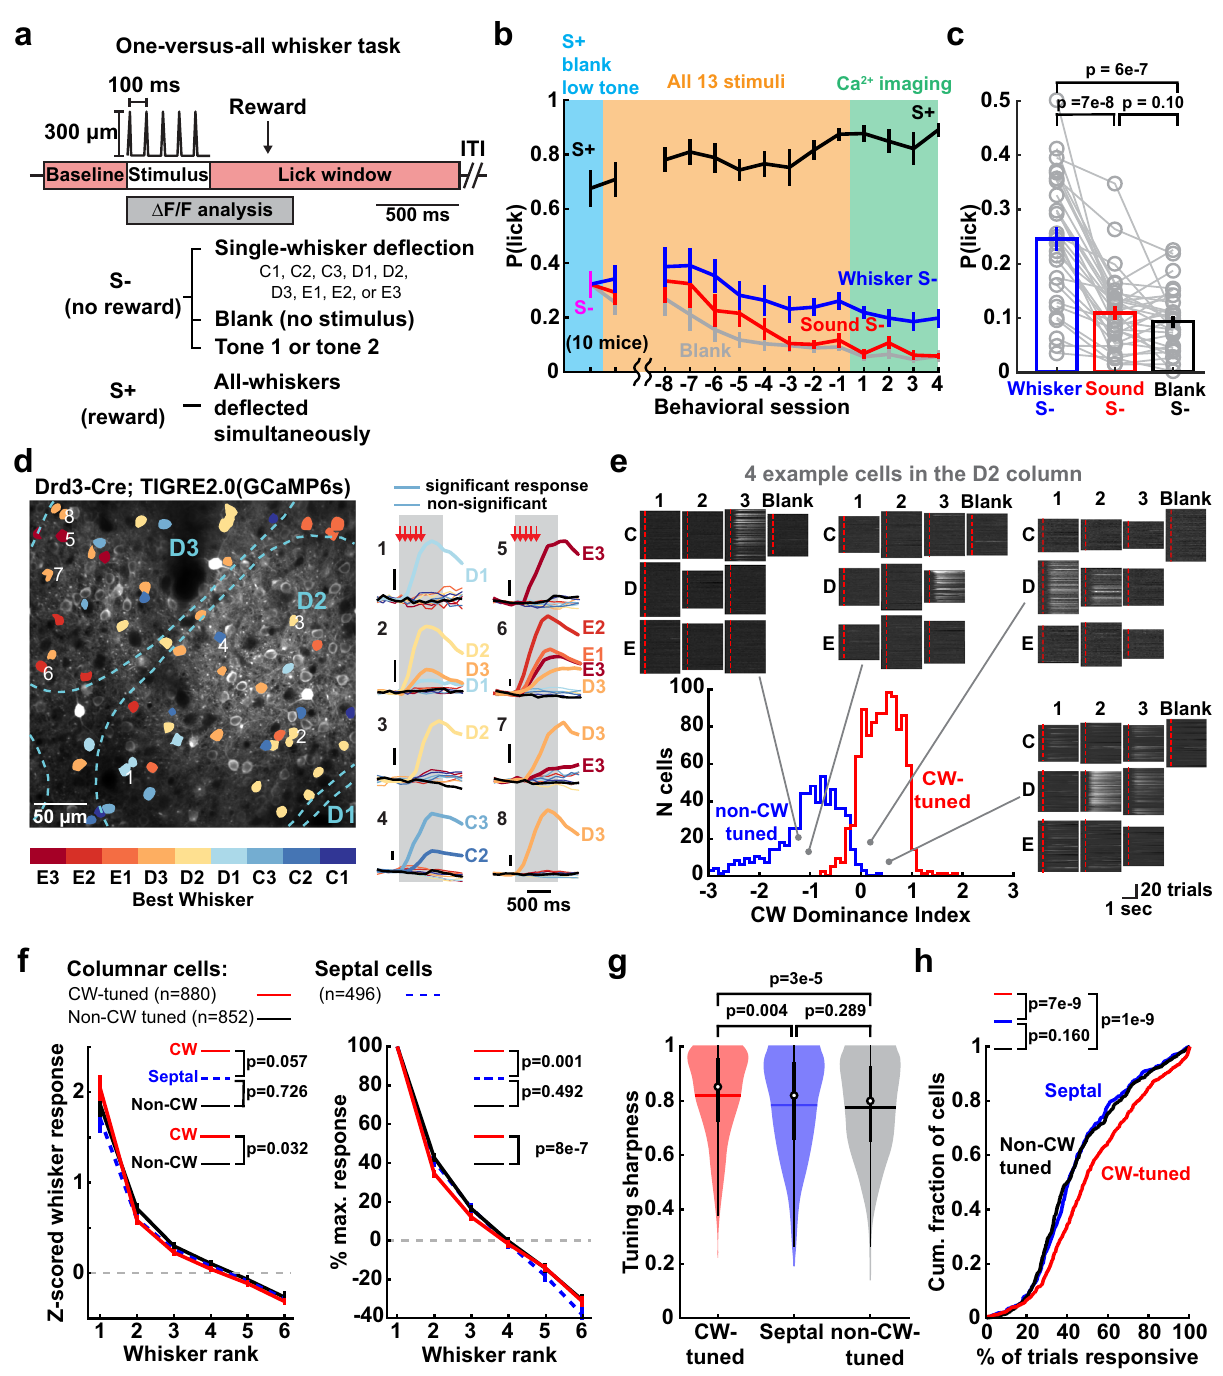
Fig. 1 | Whisker tuning of L2/3 PYR neurons in awake, whisker-attentive mice. a Trial structure and stimuli for the one-versus-all whisker task. b Behavioral per- formance after training on a partial stimulus set (blue), during training with all S+ and S − stimuli (yellow, showing the fi rst session and the last 8 sessions prior to imaging), and once mice are experts (green, showing the fi rst 4 imaging sessions). c Lick probability for each S − stimulus type during days − 3 to − 1 in ( b ). Each line is one session in one mouse. Statistics: Friedman test, two-sided. d Example imaging fi eldshowingbarrelboundariesandGCaMP6s-expressingPYRcellscolor-codedfor BW identity. Right: mean whisker-evoked Δ F / F traces for 8 cells. Thick traces and whiskerlabelsshowsigni fi cantresponses;thintracesarenon-signi fi cantresponses; blacktracesareblanks.Arrows,whiskerde fl ection.Gray,responseanalysiswindow. e Distribution of columnar whisker dominance index (CWDI) for cells located withina column (i.e., non-septalcells).CWDI quanti fi es a cell ’ s relative responseto